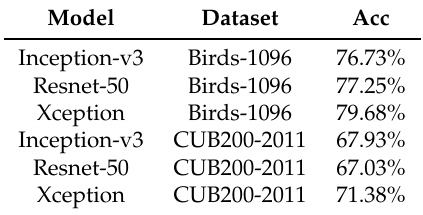
Table 1. Accuracies of the evaluated models trained on Birds-1096 and